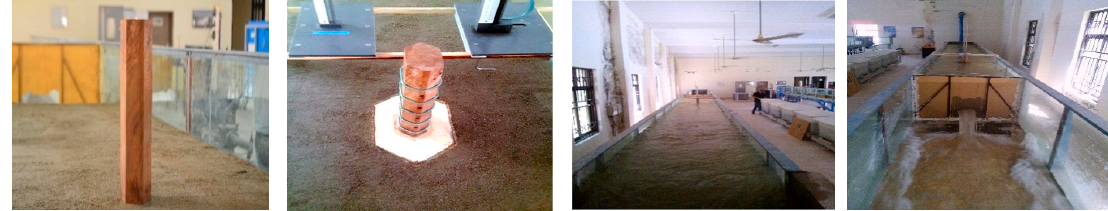
Figure 3. Details of experiments performed in the rectangular flume.